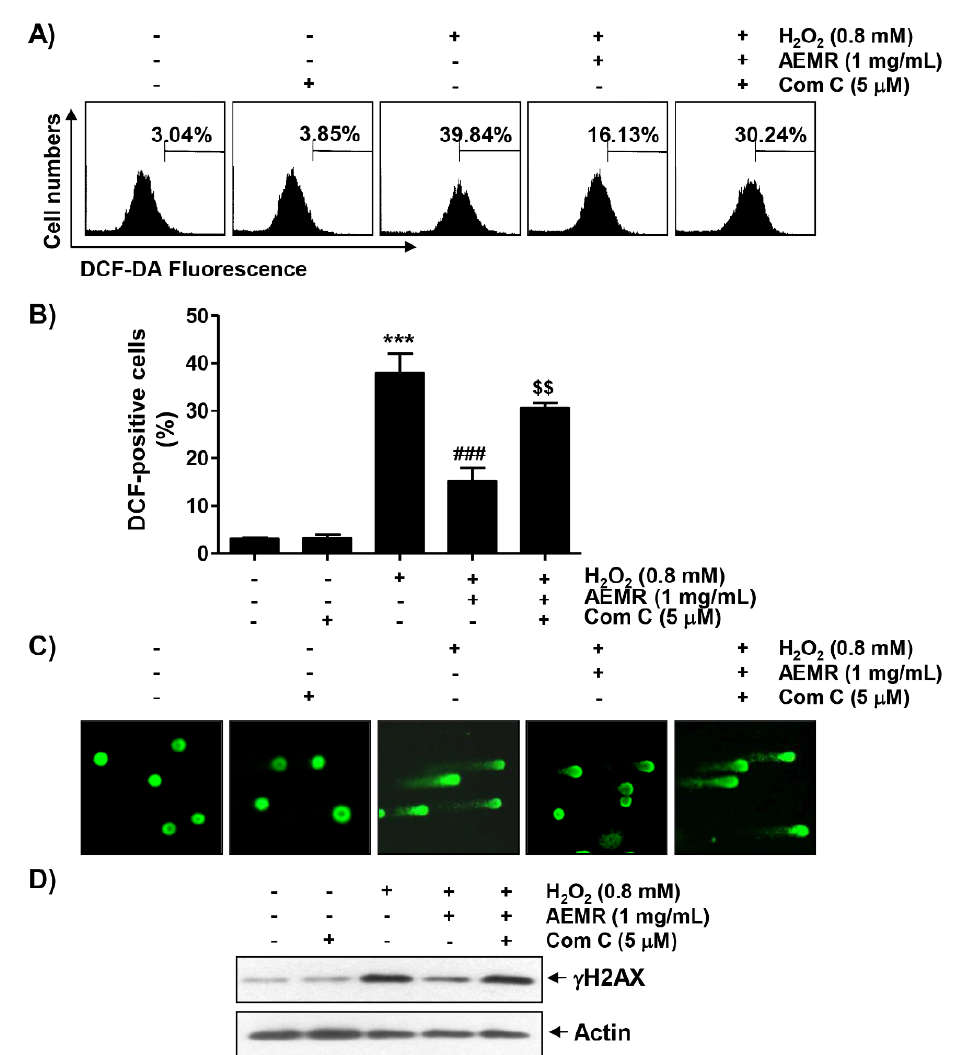
Figure 4. Effects of AMPK inhibitor on suppression of H 2 O 2 -induced ROS generation by AEMR in C2C12 cells. Cells were pretreated with 5 μM compound C with or without 1 mg/ mL AEMR for 1 h, and then subjected to treatment with 0.8 mM H 2 O 2 for 1 h ( A , B ) or 24 h ( C , D ). ( A ) Intracellular ROS levels were determined by flow cytometry after staining with 2 ′ 7 ′ -di-chlorodihydrofluorescein diacetate (DCF-DA). ( B ) Ratios of DCF-positive cells were statistically quantified. Results are ex- pressed as mean ± SD of three independent experiments (*** p < 0.001 vs. control cells; ### p < 0.001 vs. H 2 O 2 -treated cells; $$ p < 0.01 vs. H 2 O 2 and AEMR-treated cells). ( C ) DNA damage was detected by a comet assay. Representative images are shown. ( D ) For western blot analysis, extracted pro- teins were subjected to sodium-dodecyl sulfate (SDS)-polyacrylamide gel electrophoresis and then transferred to polyvinylidene fluoride (PVDF) membranes. Membranes containing proteins were probed with indicated antibodies. Anti-actin immunoblotting revealed relative amounts of protein in each lane.